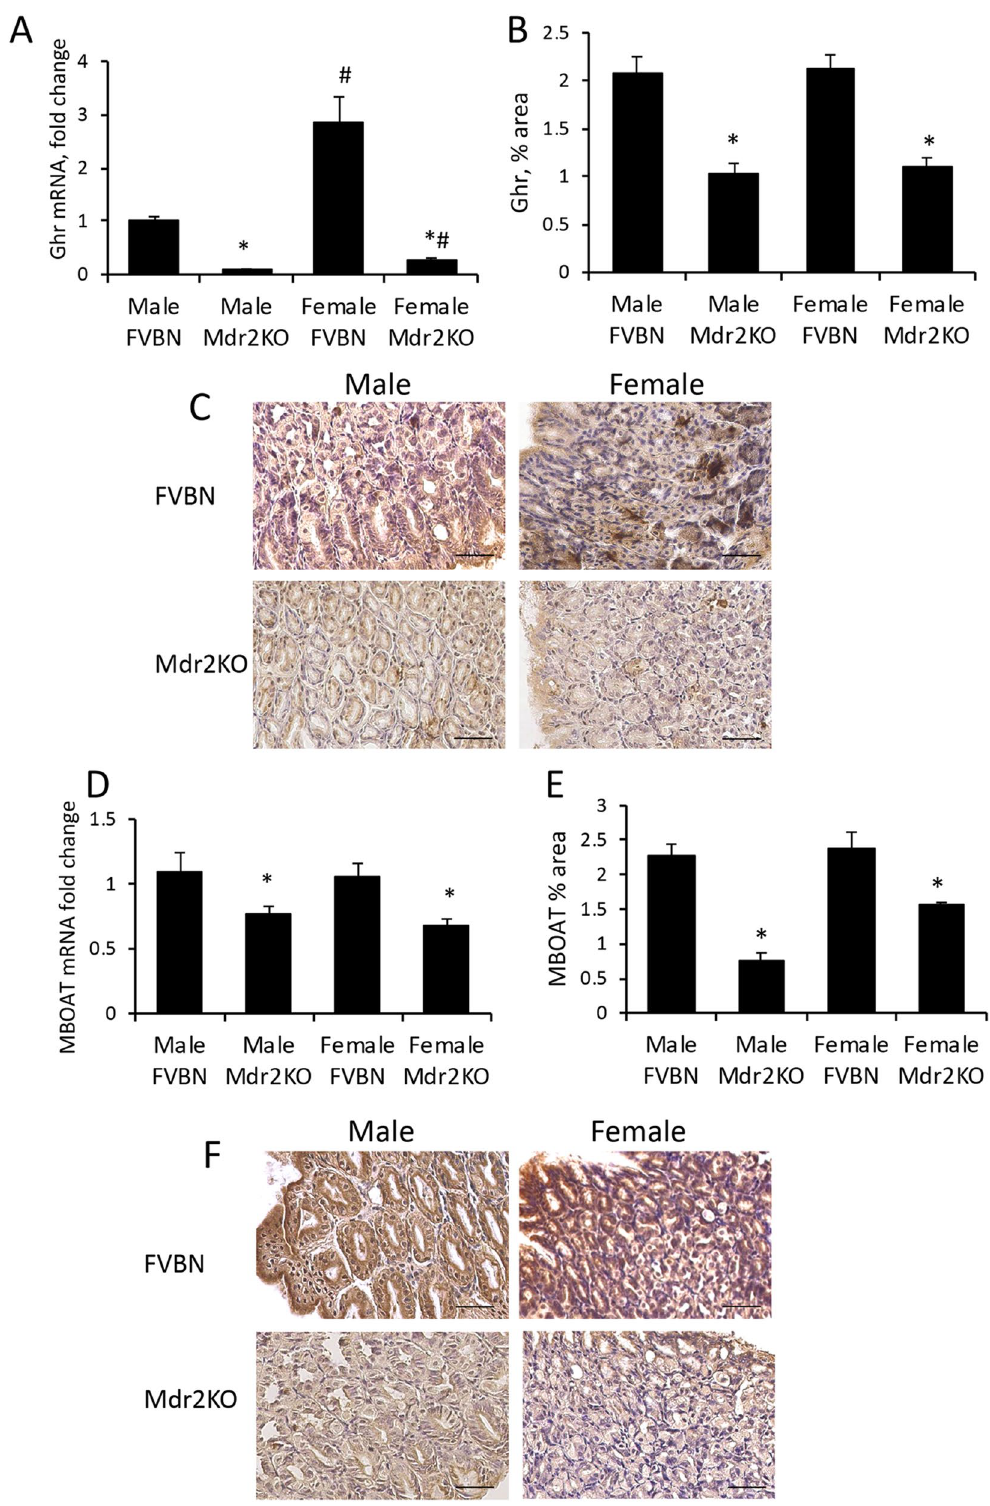
Figure 2. Gastric Ghr and MBOAT expression in Mdr2KO vs FVBN mice. Stomach tissue from 2 month old male and female Mdr2KO and FVBN mice was tested for RNA and protein expression of Ghr and MBOAT, as described in “Methods” section. (A) Ghr mRNA expression was assessed by RT-qPCR. (B) Quantification of Ghr by analysis of IHC images as shown in (C) . (D) MBOAT mRNA as assessed by RT-qPCR. (E) Quantification of MBOAT by image analysis of IHC images. (D) representative images of MBOAT IHC. Number of animals, 4. Number of sample replicates for RT-qPCR, 3. For IHC: 10 images at × 20 magnification for each scanned IHC liver section were taken and analyzed using Image J software, as described in the Methods section. p < 0.05. *, Mdr2KO vs FVBN mice. #, Female vs